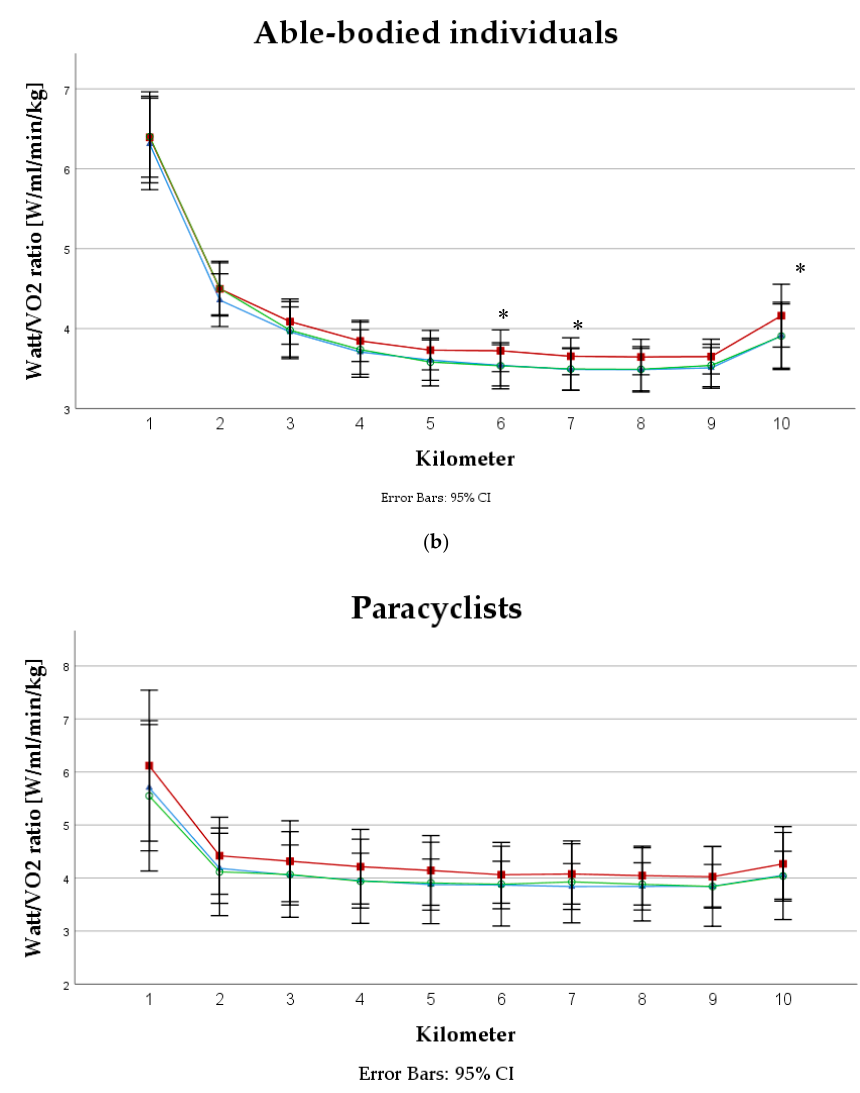
Figure 1. PO to VO 2 ratio in ( a ) able-bodied individuals and ( b ) in paracyclists during a 10 km handcycling TT. Note: * = significant di ff erence ( p < 0.05), red squares ( (cid:4) ) = beetroot juice intervention, blue triangles ( (cid:78) ) = sodium nitrate intervention and green circles (